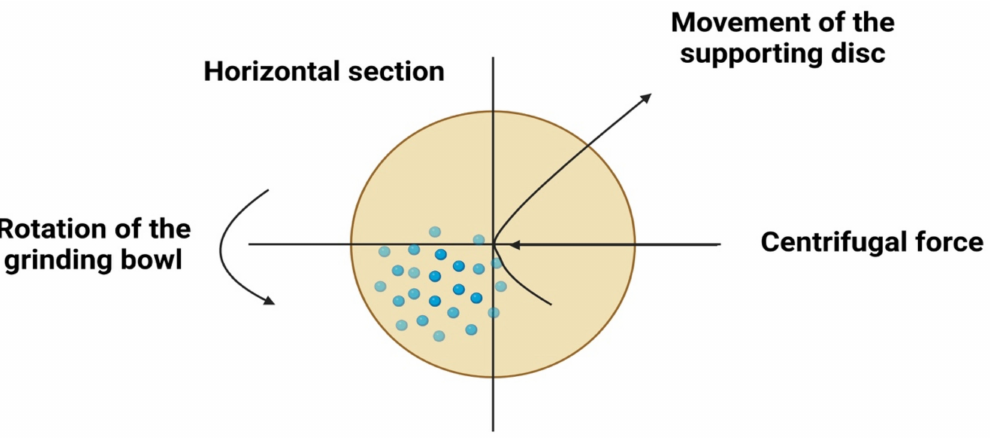
Figure 8. Diagrammatic representation of the stages required for metallic NPs synthesis (for example ZnO-NPs) employing high-energy ball milling